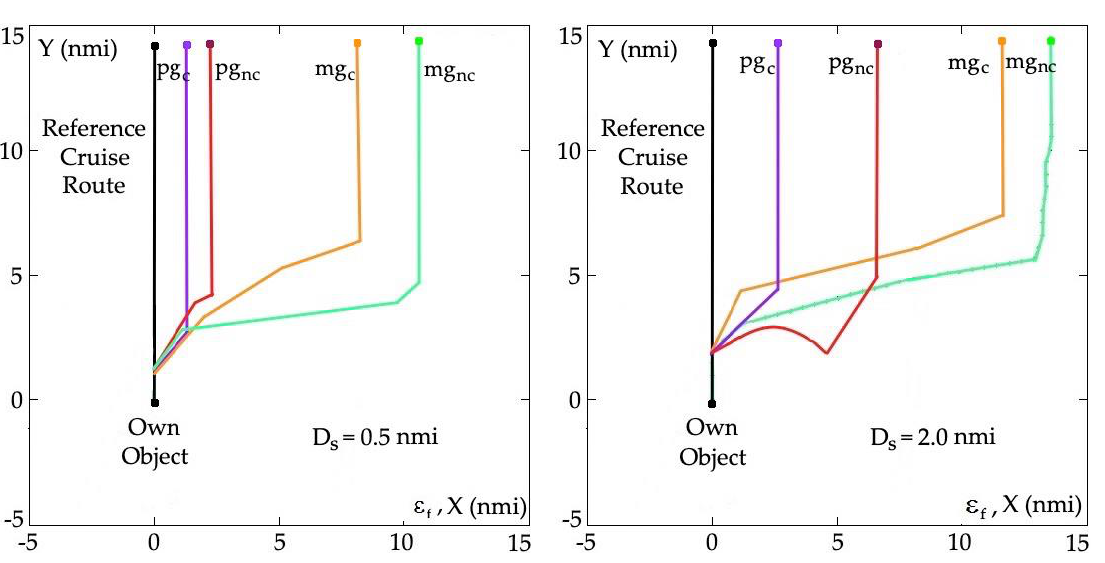
= 0.5 nmi (left) and in s